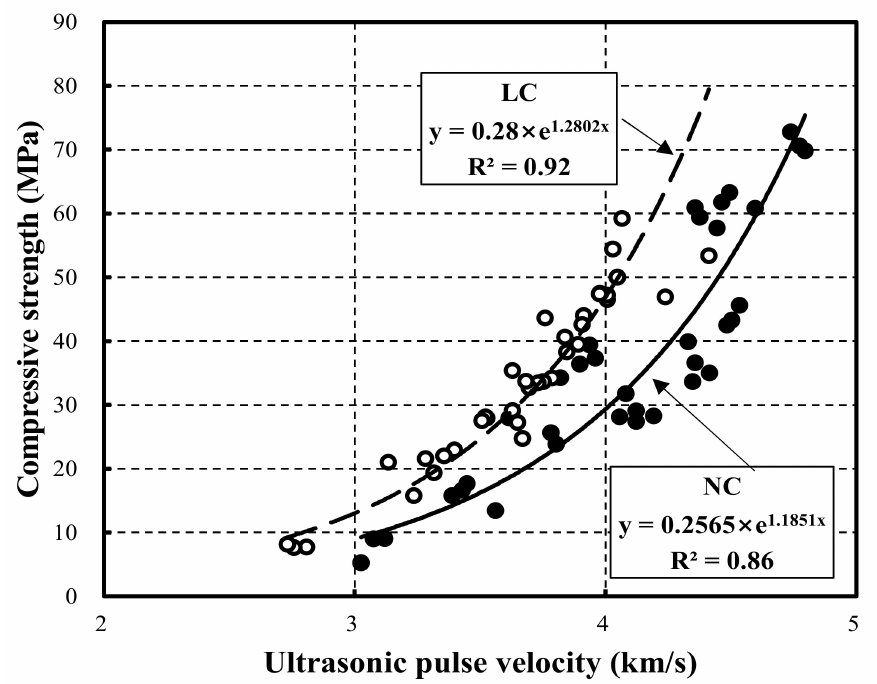
Figure 8. Relationship between compressive strength and ultrasonic pulse velocity in the estima- tion